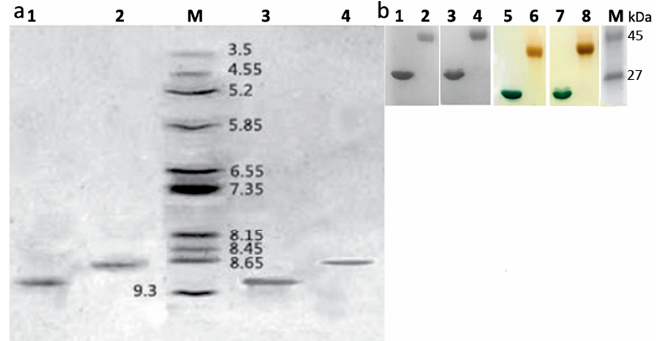
Figure 4. Electrophoresis analysis of RIPs and mPEG-SC-RIPs by IEF and gradient PAGE. ( a ) IEF; lane 1: MAP30; lane 2: mono-PEGylated MAP30; lane M: broad pI calibration kit with amyloglucosidase, 3.5; soybean trypsin inhibitor, 4.55; β -lactoglobulin A, 5.2; carbonic anhydrase B bovine, 5.85; carbonic anhydrase B human, 6.55; myoglobin horse, 7.35, lentil lectin-acidic band, 8.15; lentil lectin-middle band, 8.45; lentil lectin-basic band, 8.65; and trypsinogen, 9.3; lane 3: α -MMC; lane 4: mono-PEGylated α -MMC; ( b ) Gradient PAGE; lanes 1, 2, 3, and 4 represented α -MMC, mPEGylated α -MMC, MAP30, and mPEGylated MAP30 stained by Coomassie brilliant blue; lanes 5, 6, 7, and 8 represented the same while stained by iodine potassium. Lane M represented the LMW calibration kit (ovalbumin, 45 kDa; carbonic anhydrase, 27 kDa).